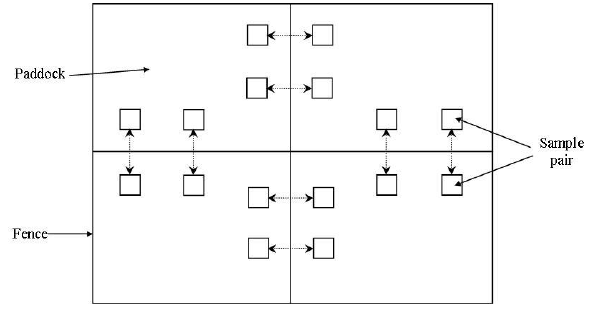
Figure 1. Cross-fence sampling